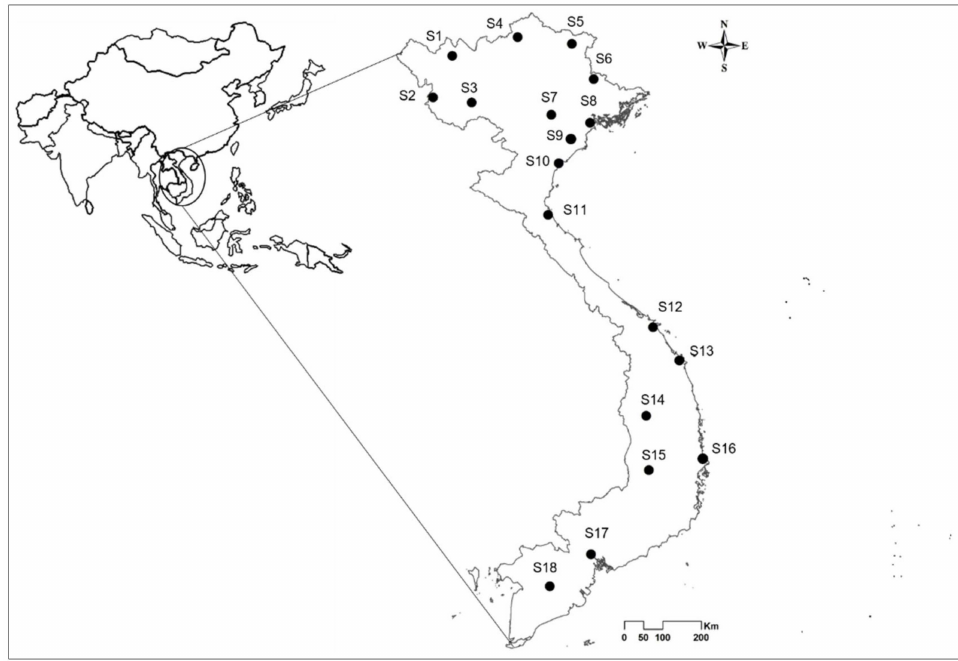
Figure 1. Map of study sites for Ae. aegypti and Ae. albopictus across Vietnam. Site codes are defined in Table